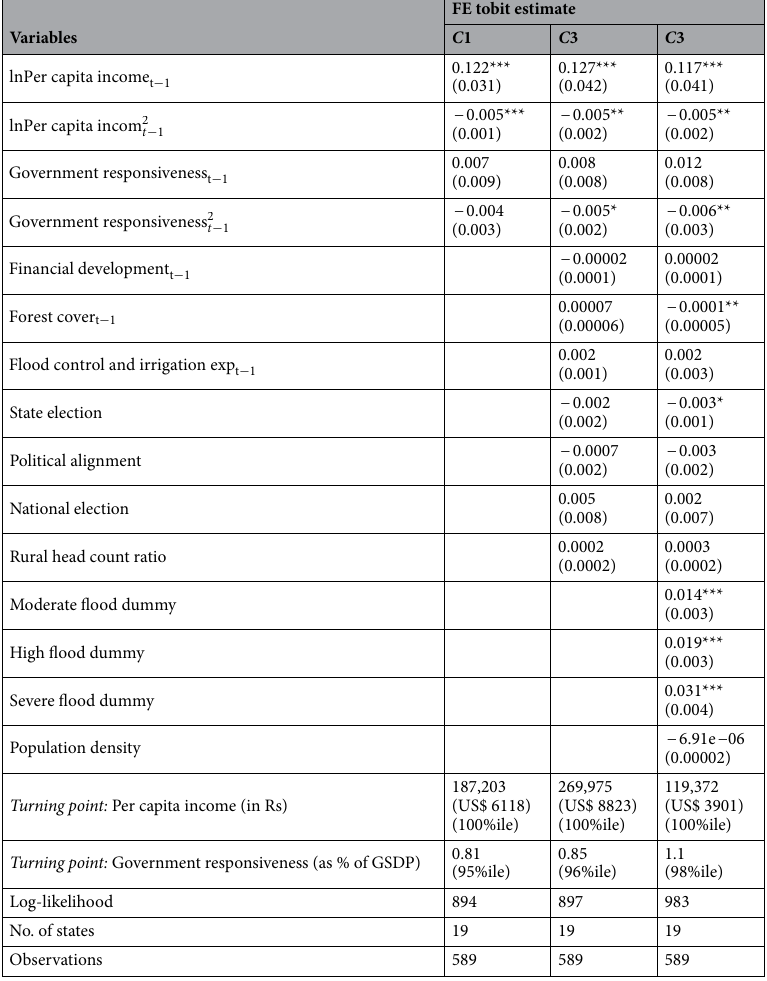
Table 3. Flood damages, per capita income, and natural calamity expenditure (All states). Clustered standard errors at state-level are reported in parentheses. The level of significance at *** p < 0.01, ** p < 0.05, * p < 0.1. The Flood Damages + 1 dependent variable is ln . Time-invariant state and year fixed effects are included in all GSDP (cid:31) (cid:30) models. The low flood is the baseline dummy